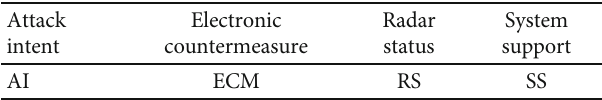
Table 3: Features of general tactical intentions.